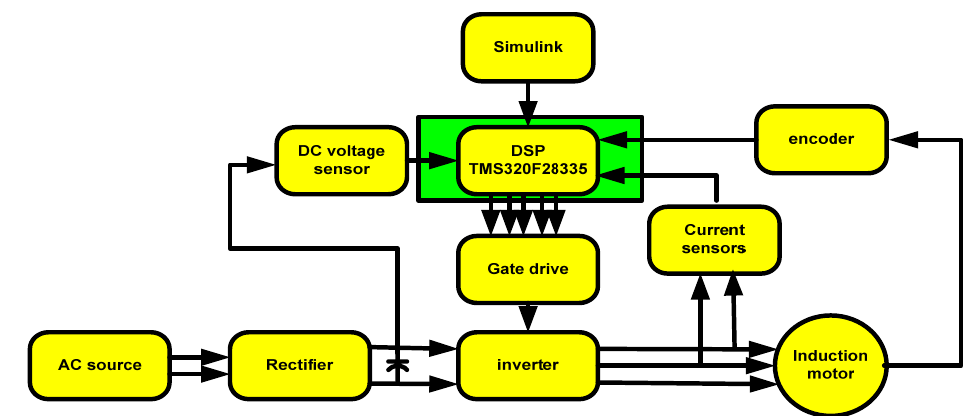
Figure 12. Hardware implementation scheme.